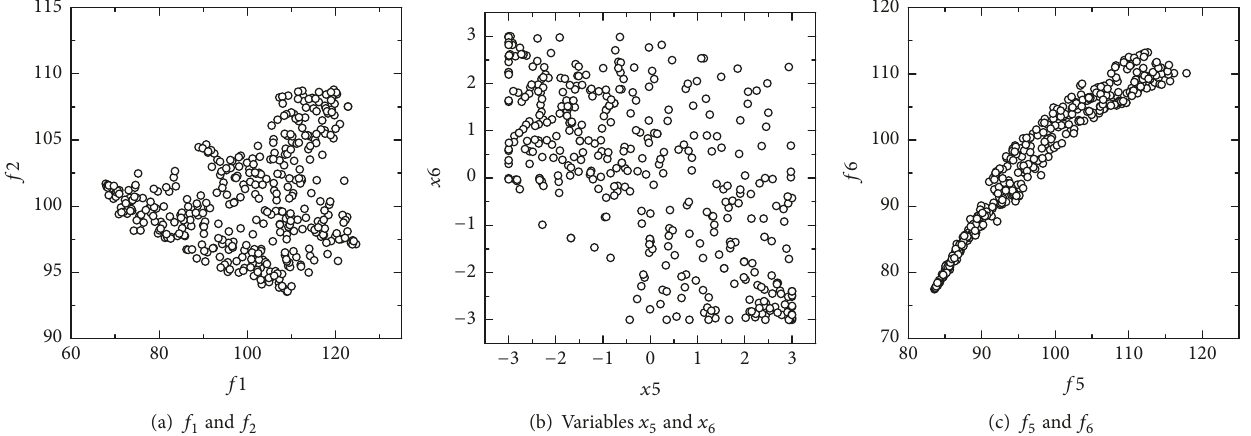
Figure 13: Results by NSGA-II on real world problem f = (𝑓 1 , 𝑓 2 ,𝑓 3 , 𝑓 4 ) .